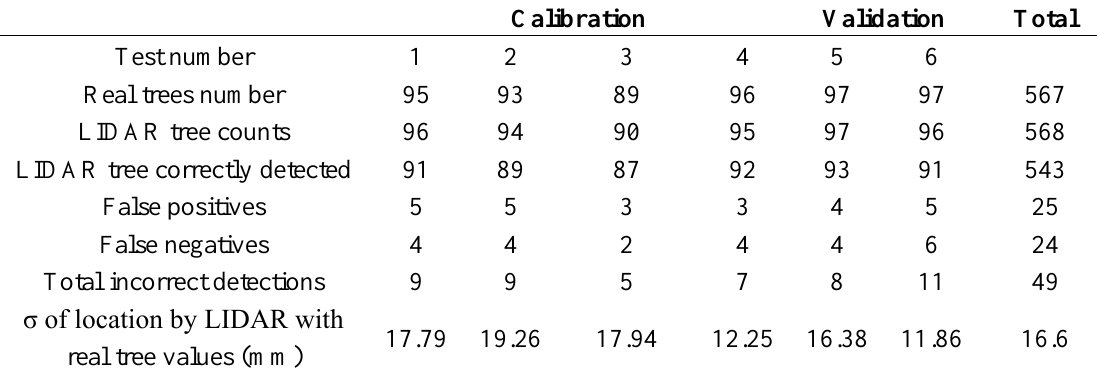
Table 6. Results obtained for stem identification with the calibration and validation samples using the parameter values selected from independent evaluations (height cut of 21, encoder range of 200, path increment of 5, cut identification of 19; jump of 1, and blanking tree distance of